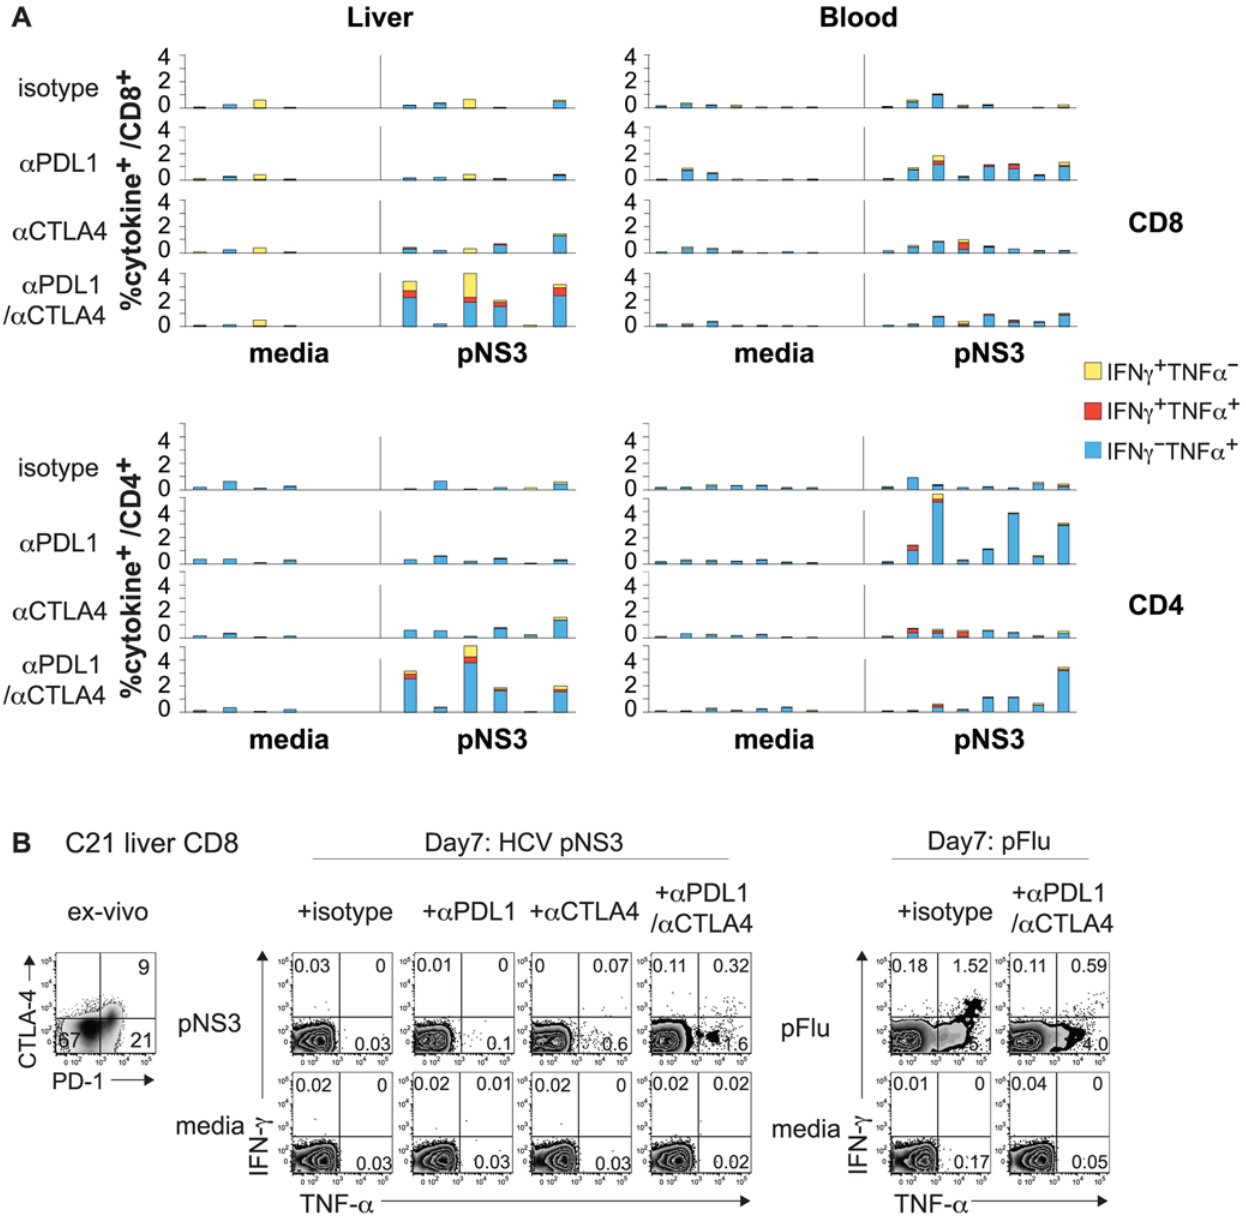
Figure 3. Intrahepatic HCV-specific T cell dysfunction can be reversed synergistically by combined PD-1/CTLA-4 blockade. (A) Effect of inhibitory receptor blockade on HCV-specific IFN- c and TNF- a production by CD8 and CD4 T cells from liver and blood. The bar graphs show the frequency of CD8 (upper graphs) and CD4 (lower graphs) T cells with HCV-specific intracellular IFN- c and/or TNF- a expression in liver-derived (left panel, n=6) and blood-derived (right panel, n=8) lymphocytes isolated from chronic HCV patients and cultured for 7 days in vitro with 15mer overlapping peptides spanning the entire HCV NS3 protein (pNS3) in the presence of isotype control or blocking antibodies. The 7-day cultures were further stimulated for 6 hours with media alone or with pNS3 before intracellular IFN- c and TNF- a staining. The %IFN- c 2 TNF- a + (blue bar), %IFN- c + TNF- a + (red bar) and %IFN- c + TNF- a 2 (yellow bar) T cells are stacked together in each case to show total cytokine + cells. (B) Representative flow cytometry plots showing HCV NS3 and Flu-specific IFN- c and TNF- a production in vitro in liver-derived CD8 T cells from chronic HCV patient C21 following 7 days of culture with NS3 or Flu-derived peptides in the presence of isotype or blocking antibodies. Flow cytometry plots on the far left shows the PD-1 and CTLA-4 expression in liver-derived CD8 T cells directly ex vivo .